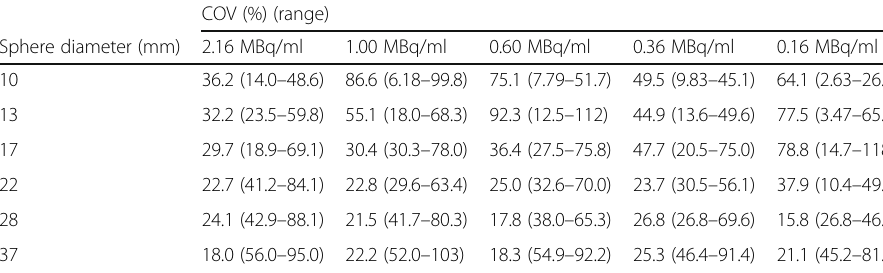
Values in parentheses represent the range of RCs (min –